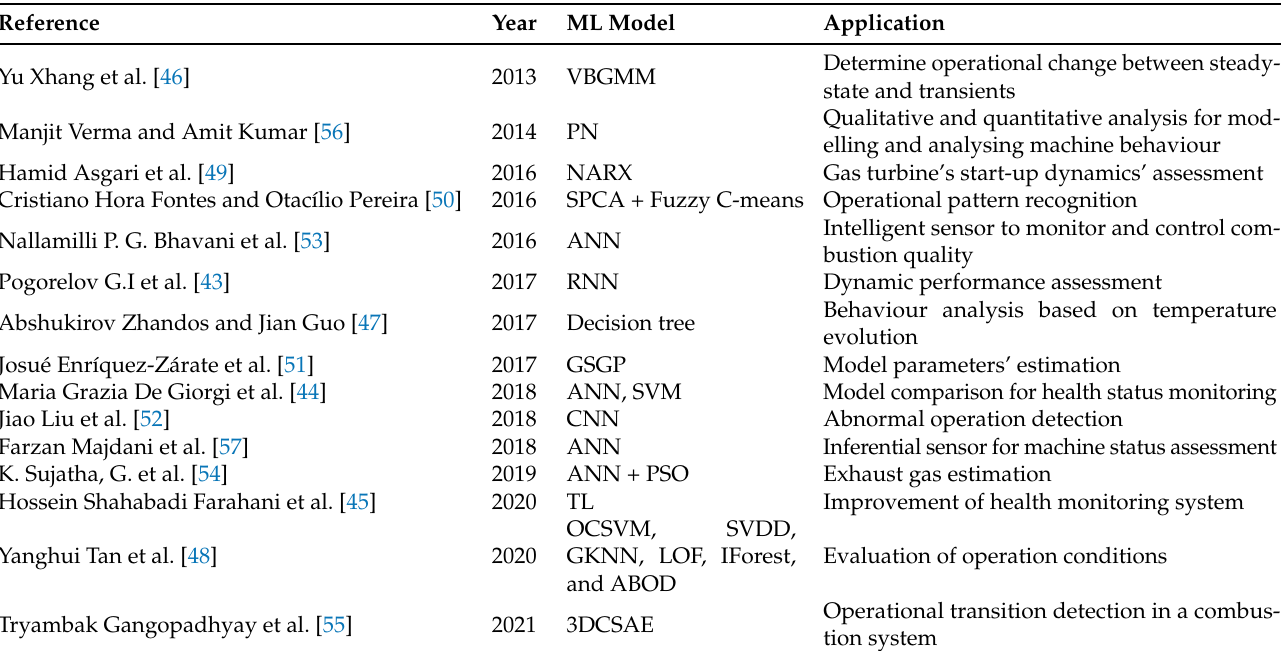
Table 1. Summary of the presented methods for health status monitoring using machine-learning